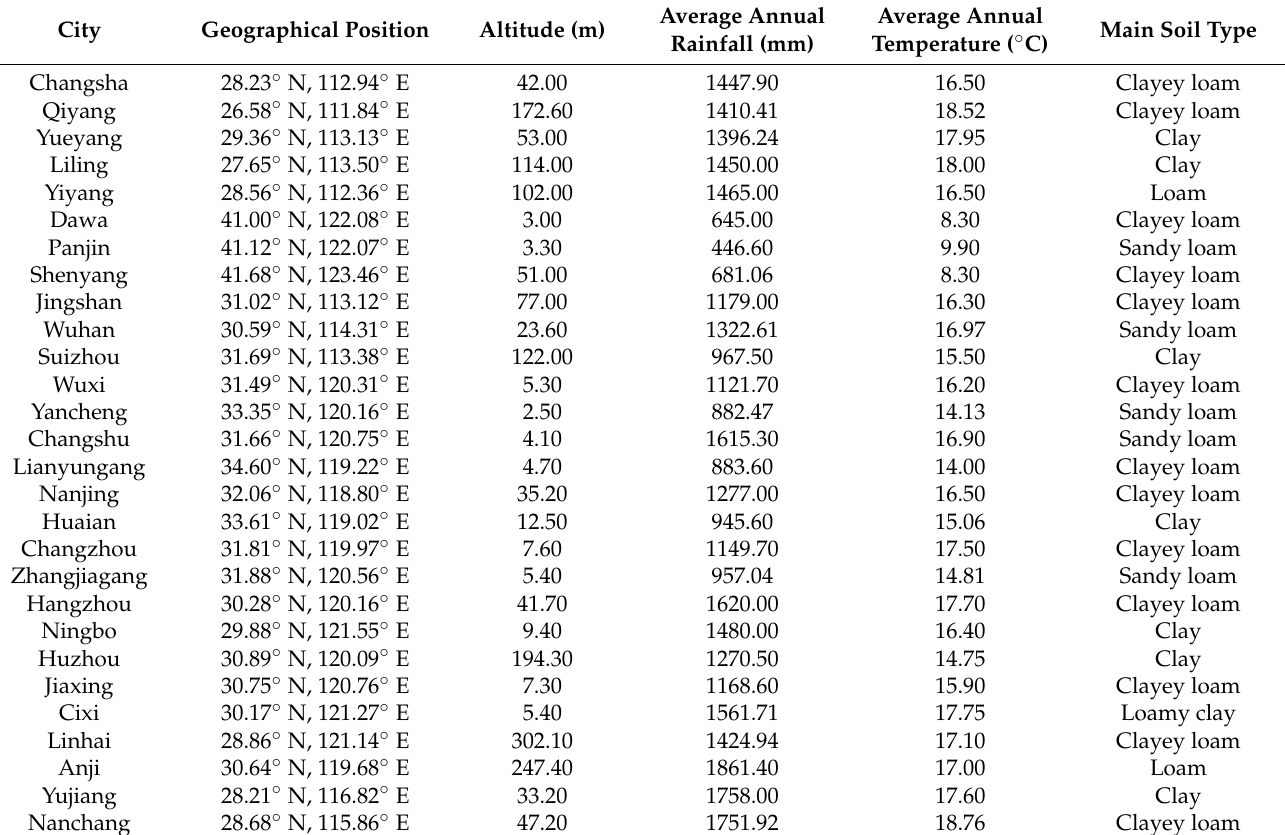
Table 5. Geographical Position and Main Characteristics of Each Site for Rice in